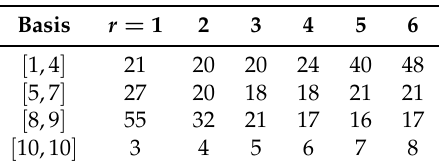
Table 3. Total bit-length for each one of the ˆ P = 4 sub-sequences of the basis (shown in Table 2) for each value of the Rice parameter ( r ). Each row of this table is implicitly calculated by Algorithm 3 in its first iteration and stored in variable y r for further usage.